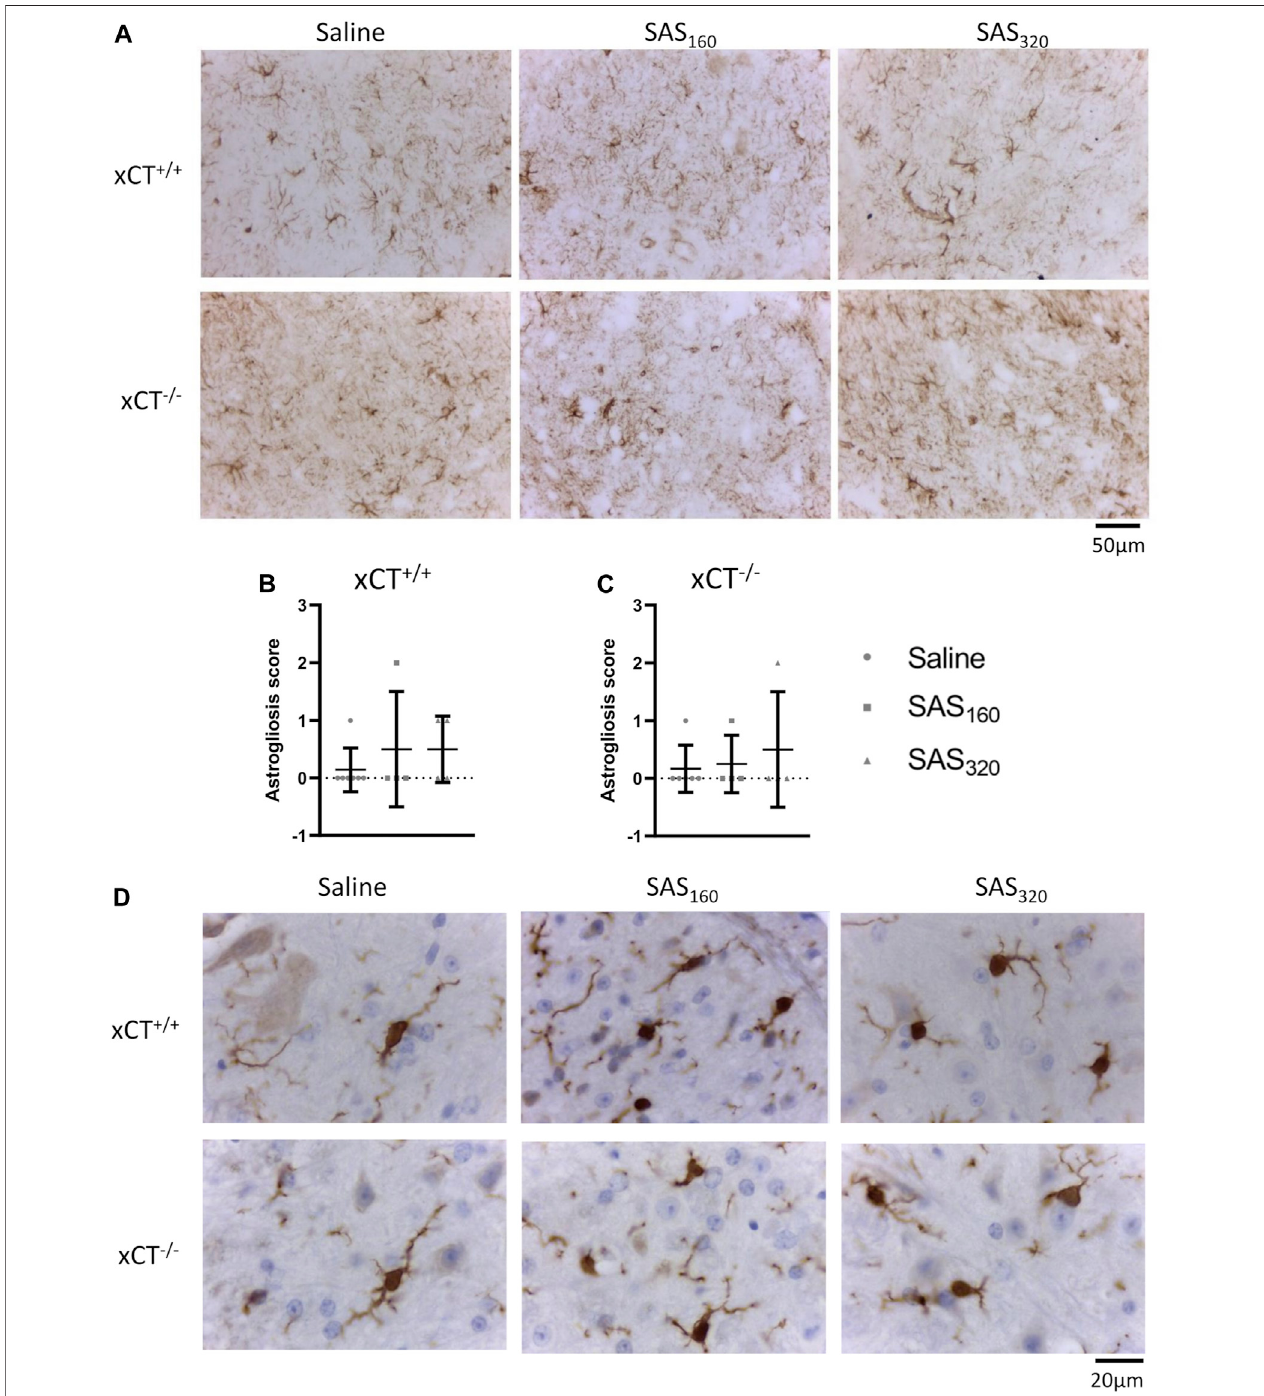
FIGURE 9 | Effects of chronic sulfasalazine (SAS) treatment on astrocytes and microglia in the spinal cord. Representative photomicrographs of GFAP immunohistochemicalstaining (A) .Theextentofastrogliosis(normal(0)orpresenceofslight(1),mild(2)orsevereastrogliosis(3))wasquanti fi edinxCT +/+ (B) andxCT − / − (C) mice. Data arepresented asmean ± SEM and analyzed using a Fisher ’ s exact test tocompare normal GFAP staining(score 0) with signs ofastrogliosis (scores 1 – 3) for each dose ofSAS compared to saline. Representative photomicrographs ofIba-1 immunohistochemical staining after a wash-out period of one week (D) . One slice of n (cid:2) 4 – 7 mice/group (for GFAP) or n (cid:2) 5 – 11 mice/group (for Iba-1) was used.